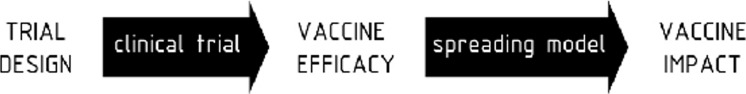
Scheme of the basis for evaluation of anti tuberculosis vaccines in absence of universally reliable protection correlates.First stage: design of vaccine efficacy determination clinical trials: the age of the cohorts must be elected taking into account that prior exposure to mycobacteria—either environmental, M. tuberculosis after exposure or even prior TST or also BCG—may corrupt the observed vaccine efficacies. Second stage: vaccine impact evaluations: bulk, short-term and long-term impact forecasts should be equally considered, as well as age-distributed impacts in terms of cases, infections and casualties prevented.